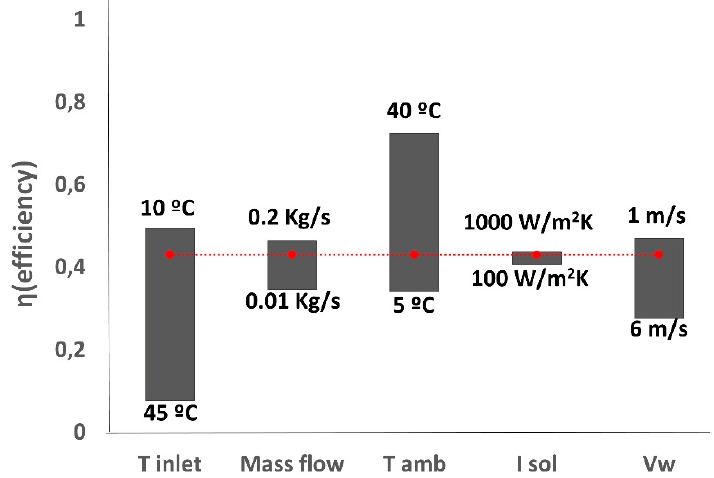
Figure 16. Summary of the parametric study representing the maximum and minimum achievable efficiency values.